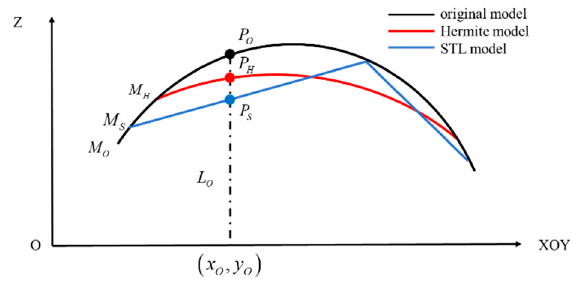
Figure 10. Local schematic of model fitting error.